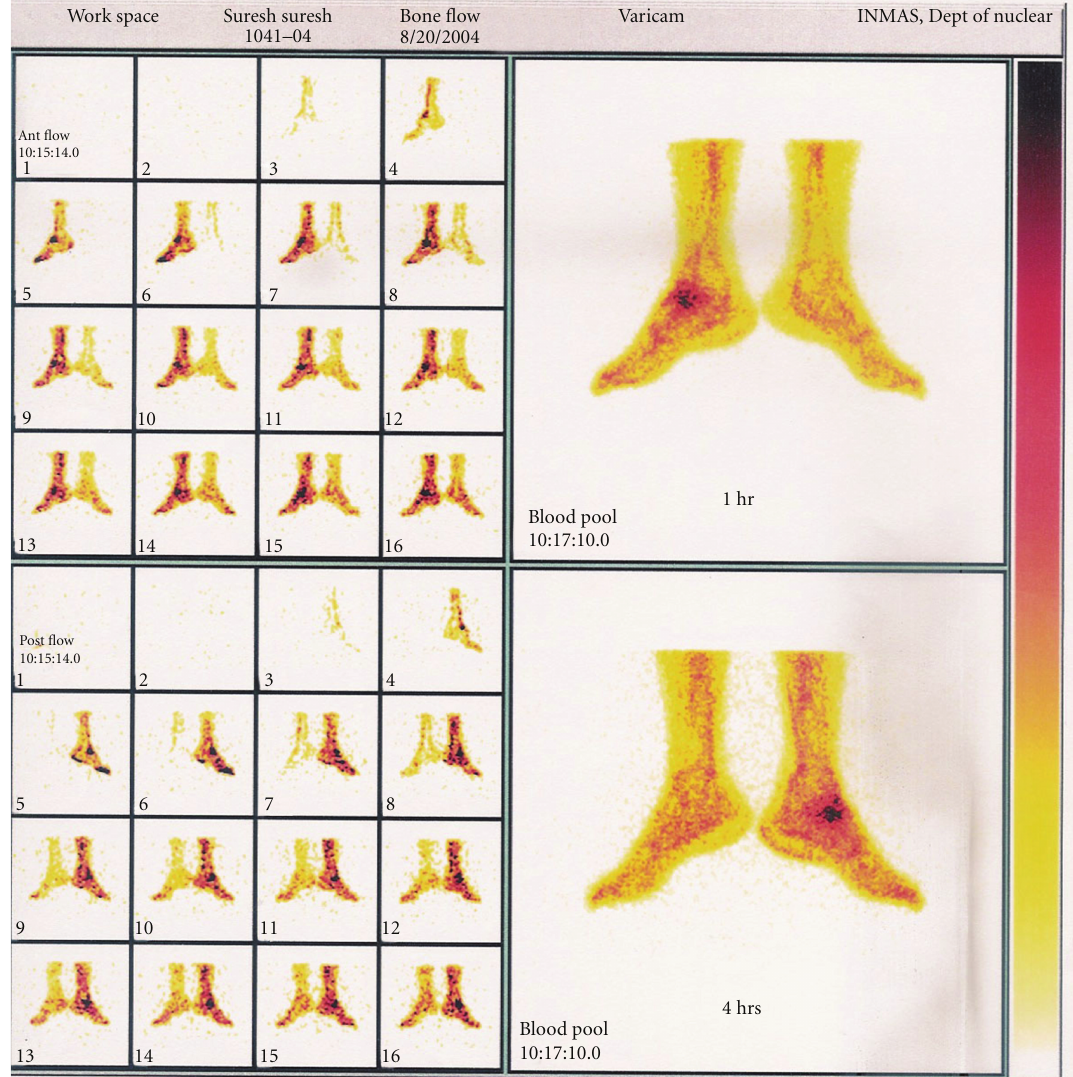
Figure 3: SPECT and scintigrams of patient, showing preferential localization of radiotracer in the ankle lesion after 1hr and 4 hours postinjection of 370 MBq of 99m Tc-EMB.